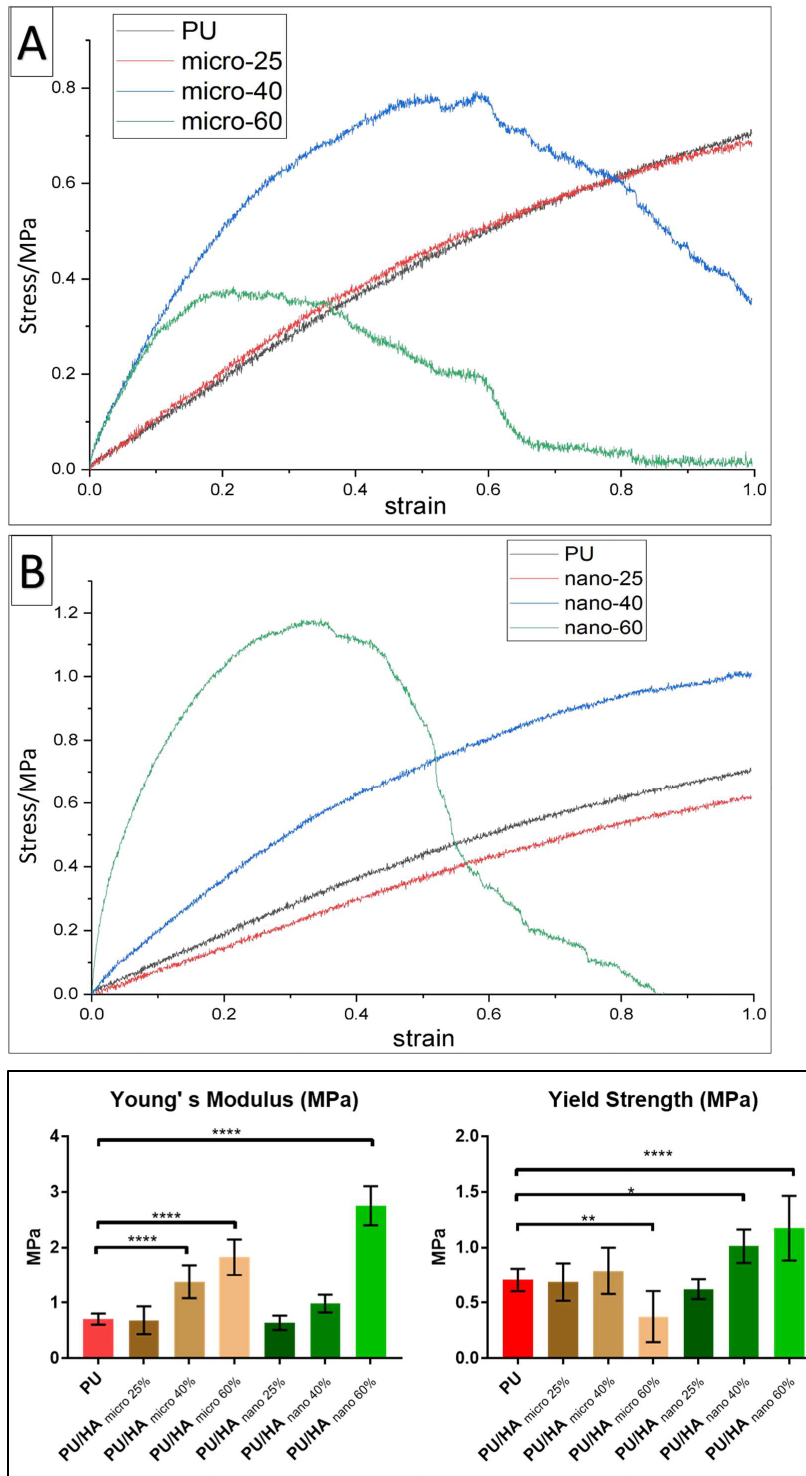
Figure 8. show stress/strain curves of PU and PU/HA scaffolds with 25%, 40% and 60% HA micro ( A ) and nano ( B ) particles respectively, note the different scale bars. Young’ s modulus and yield strength of scaffolds with statistics. Differences between two groups were distinguished as statistically significant if p ≤ 0.05 (*), p ≤ 0.01 (**) and p ≤ 0.0001 (****). (For the samples which are not broken in the tensile mechanical testing, the stress of the final point is considered as their yield strength.) Figure 8B compares PU and PU/HA nano 25%, 40% & 60% under tensile testing. Similar to the PU/HA micro 25% scaffold, the PU/HA nano 25% scaffolds have the lowest Young’s modulus (0.64 MPa) and yield strength (0.62 MPa), even lower than PU scaffolds (0.71 and 0.71 MPa, respectively). Moreover, by increasing HA nano percentage up to 40% and 60%, the Young’ s modulus and yield strength increase rapidly, indicating that the PU/HA nano 60% scaffolds have the highest Young’s modulus (2.75 MPa) and yield strength (1.17 MPa) by a significant margin, but fail more often. All scaffolds (PU, PU/HA nano 25% and 40% ) were not broken under the tensile test, except for the PU/HA naon 60% scaffolds. PU/HA nano 40% scaffolds are a promising percentage to be selected, due to the increased Young’s modulus and yield strength (0.98 and 1.01 MPa, respectively), as well as an increased ability to bear more strain compared to others. PU/HA nano 40% shows suitable mechanical properties in this group (Figure 8). Figure 8A shows the tensile test curves of PU and PU/HA micro 25% scaffolds which are similar but confirm that PU/HA nano 25% scaffolds have low mechanical properties. This can be due to the low percentage of HA in HA scaffolds. However, PU and PU/HA micro or nano 25% are not broken during the tensile test. Both the PU/HA micro or nano 40% scaffolds lead to an improvement in mechanical strength. Even though the Young’s modulus of PU/HA micro 40% scaffolds (1.38 MPa) is higher than that of nano (0.98 MPa), PU/HA nano 40% scaffolds have higher yield strength (1.01 MPa) than that with micro (0.79 MPa). During the tensile test, the PU/HA nano 40% survive, indicating a better ability to undergo strain. However, the PU/HA micro 40% scaffolds broke. Both the PU/HA micro and nano 60% scaffolds have high Young’s moduli (1.82 and 2.75 MPa, respectively) but this is significantly higher with nano HA. However, the yield strength with PU/HA nano 60% scaffolds increases (1.17 MPa) compared to PU scaffolds (0.71 MPa), whereas with PU/HA micro 60% scaffolds this is lower (0.38 MPa), see Figure 8. 2.4. Cell Viability The PU and PU/HA micro and PU/HA nano scaffolds were seeded and evaluated using Human Osteosarcoma cell line MG63. As shown in Figure 9, all scaffolds showed an increase in cell metabolic activity, which indicates there is cell growth during the 28 day culture period. MG63 cells cultured on PU scaffolds had the highest metabolic activity on